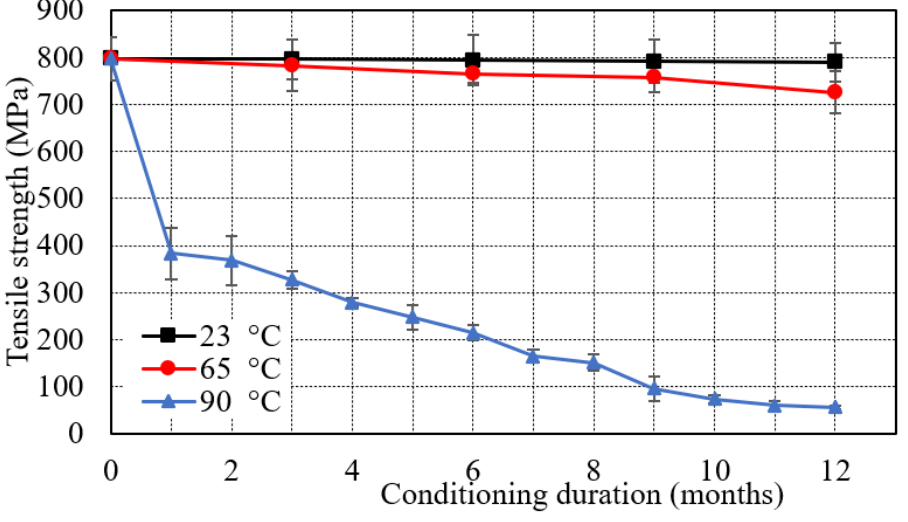
Figure 4. Effect of seawater immersion on tensile strength.